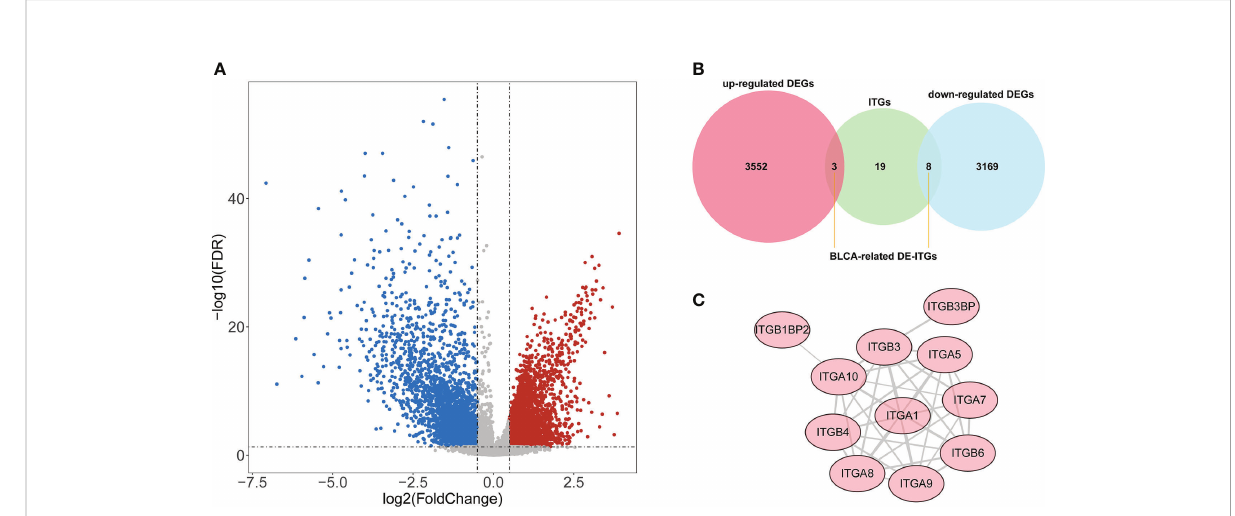
FIGURE 1 Identi fi cation of BLCA-related DE-ITGs. (A) 6732 DEGs were identi fi ed between BLCA and normal groups from the TCGA cohort . (B) 11 ITGs were illustrated from DEGs by the Venn diagram. (C) PPI network of